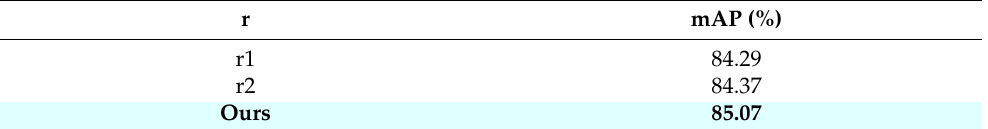
Table 7. Effect of different original image scaling ratios and width-to-height distortion ratios on detection